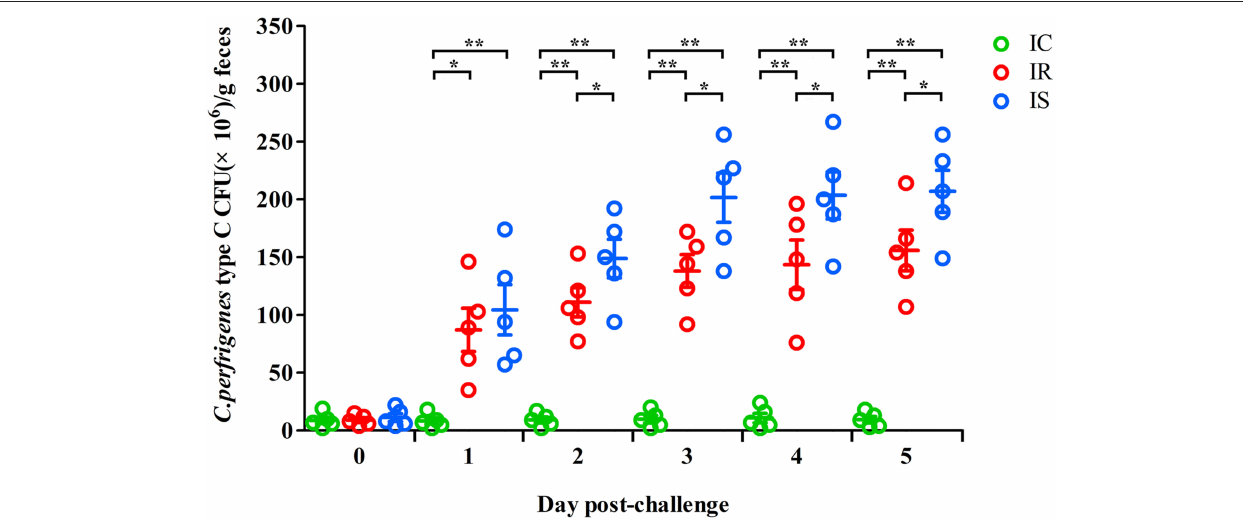
FIGURE 1 | The fecal shedding levels of piglets in IR, IS, and IC groups from 0 to 5 days post challenge (dpc). Fecal shedding CFUs were determined by plate count method. The horizontal line represents the mean. Green circle represents results of IC; Red circle represents results of IR; Blue circle represents results of IS. An asterisk denotes a significant difference (* P < 0.05; ** P < 0.01).